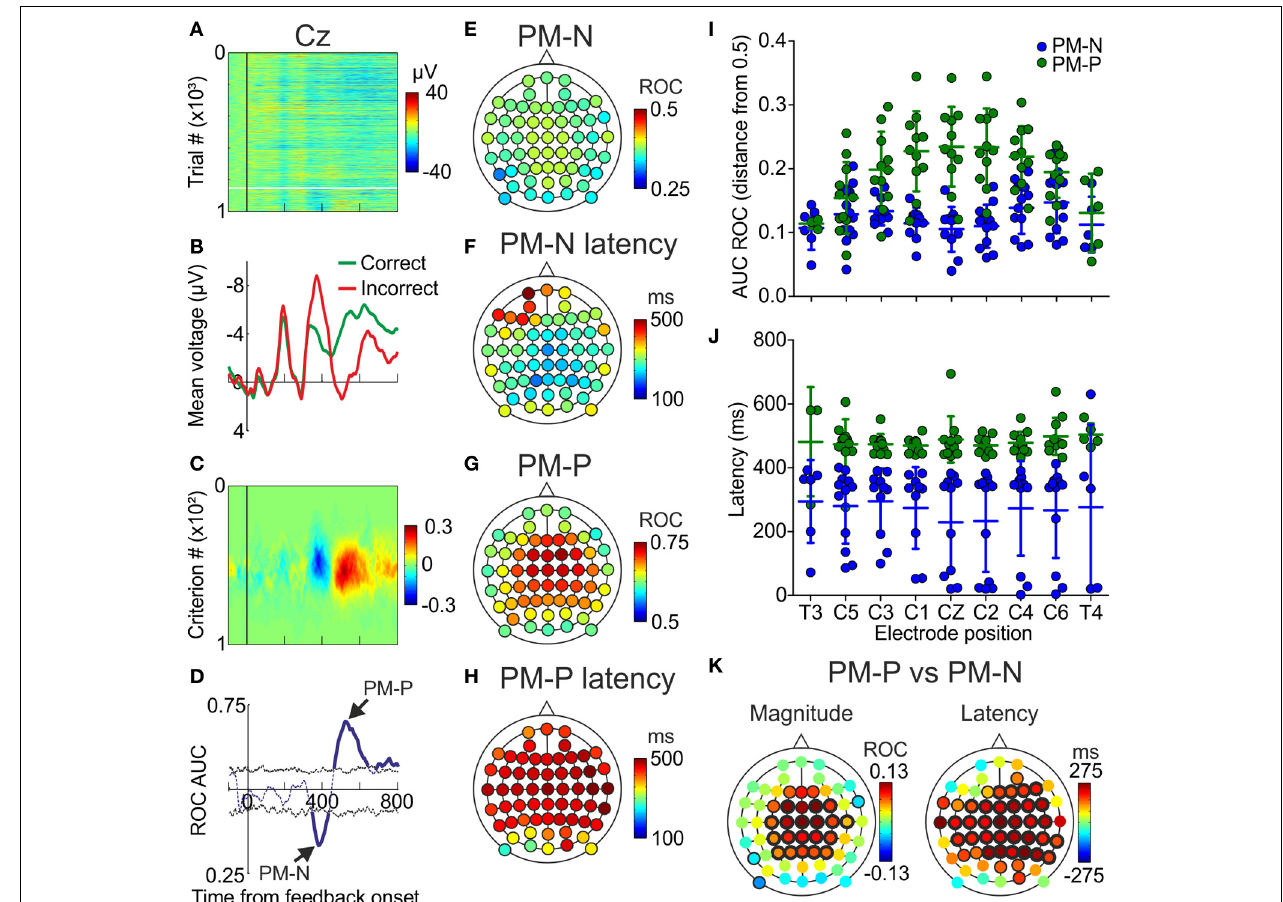
FIGURE 3 | Trial-by-trial results. (A) Voltage, as a function of time, recorded in the electrode located at CZ of one example participant; each line represents a trial and the color code, from blue to red, the voltage; vertical black line indicates the presentation of the feedback; horizontal white line separates correct (upper) from incorrect (lower) trials. (B) Voltage averaged across correct and incorrect trials, as a function of time, in the same electrode location. (C) Difference between p FAs and p Hits, as a function of time and criterion, calculated from data in (A) . (D) AUC ROC as a function of time, for the same electrode. (E,G) Minima (PM-N) and maxima (PM-P) values of the AUC ROC comparing correct vs. incorrect trials averaged across the sample ( N = 12 participants). Color code, from blue to red, indicates the AUC ROC values. (F,H) Latencies at minimum and maximum of the AUC ROC averaged across the sample